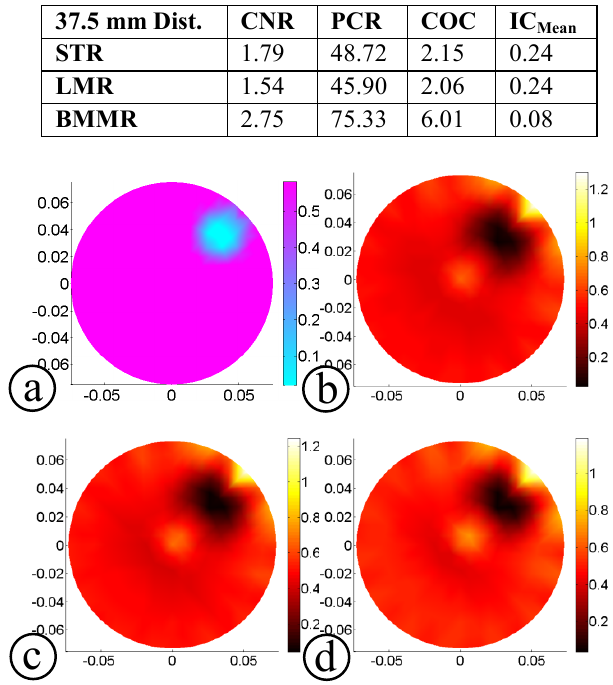
Fig .13: Conductivity reconstruction of the phantom with inhomogeneity (D = 35 mm, L = 52.5 mm) near electrode No.-3 ( λ = 0.0001 ): (a) original object, (b) image with STR, (c) image with LMR, (d) image with